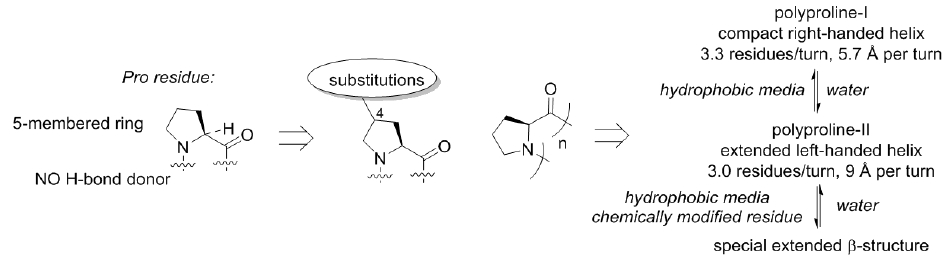
Figure 6. The structure diversity of the Proline